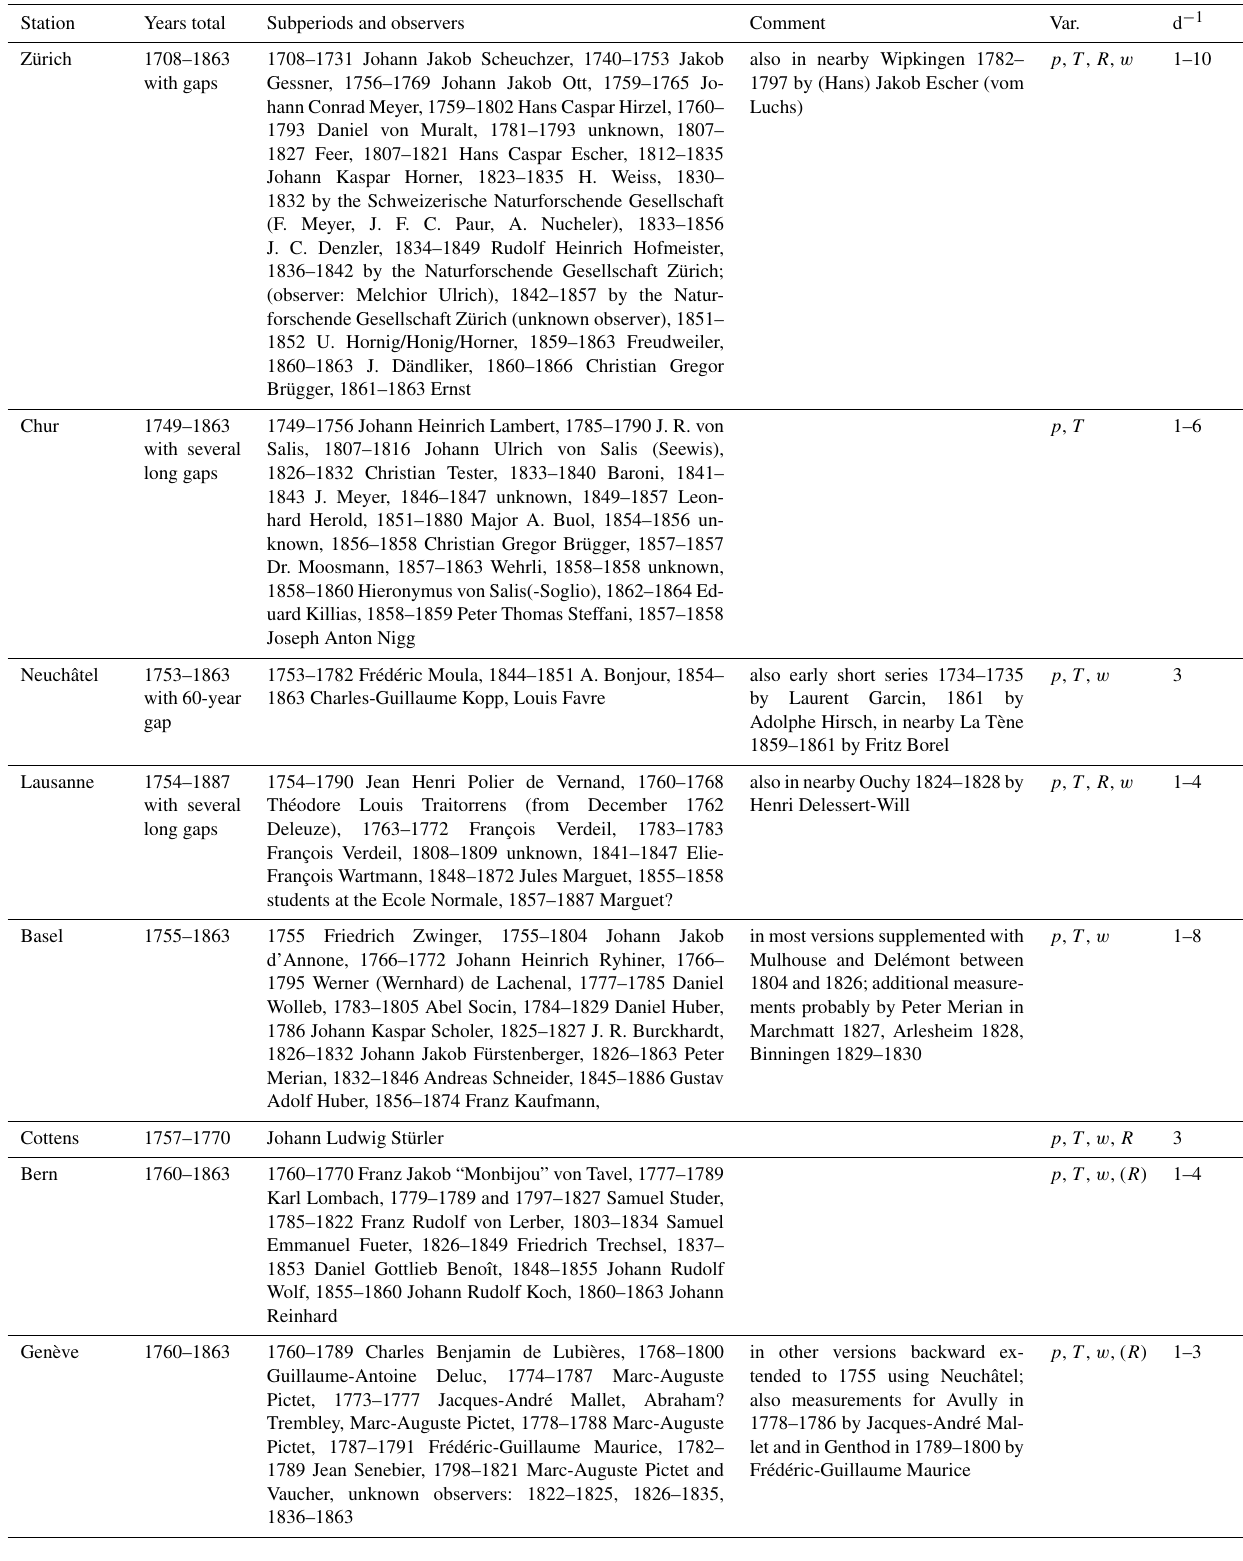
Table 2. Summary inventory of all stations with at least 10 years of data, summarised per station (variables: p – pressure, T – temperature, w – wind, R – precipitation, d − 1 – the number of measurements per day). Station names are sorted by the start year of the series and indicated in the corresponding local